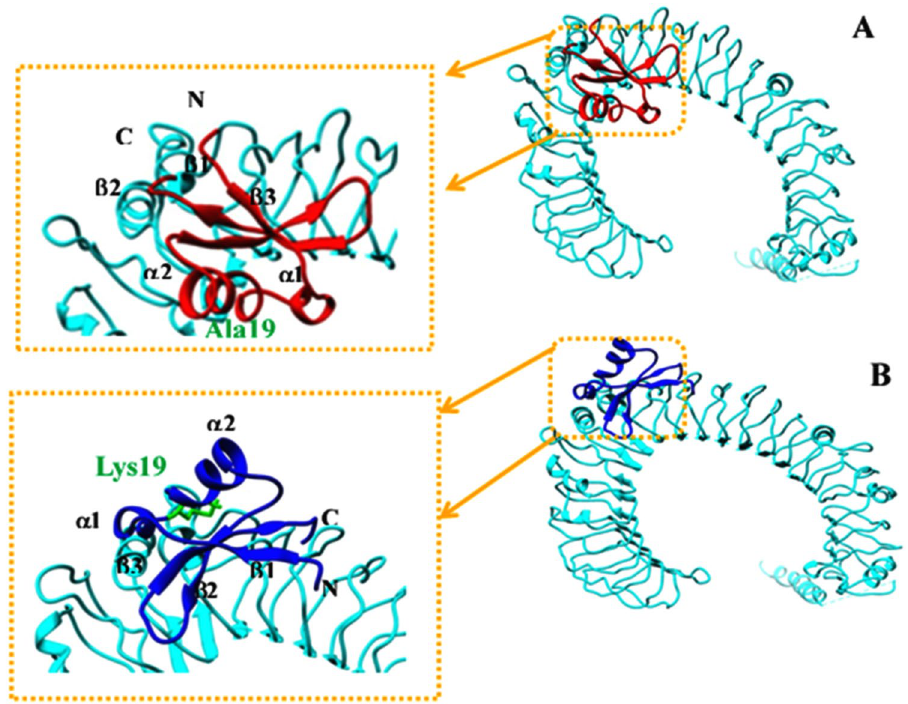
Figure 1. Solution NMR structures of the Brazzein with hTLR5. ( A ) wild-type (WT) of Brazzein interacts with near concave β-sheet domain of hTLR5. ( B ) The substitution Ala 19 with Lys near the α2-helixes sites of Brazzein bond to hTLR5. The N- and C-terminals are denoted by N- and C-, respectively.